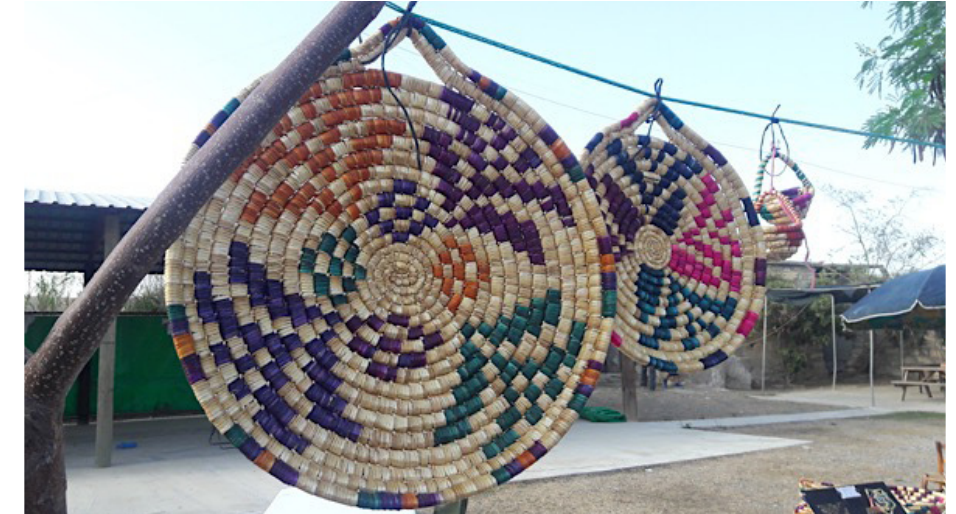
Figure 2. Traditional sestas . Photograph by the author. wall, which include piron (fork), potin (shoes), iskemle (chair), gabira (toasted bread), ispaho (yarn), belesbit (bicycle), lagani (waterway), and bavuri (tin water bot‐ tle) are in the Turkish Cypriot dialect; they are not used in standard Turkish. Thus, they serve to represent a sym‐